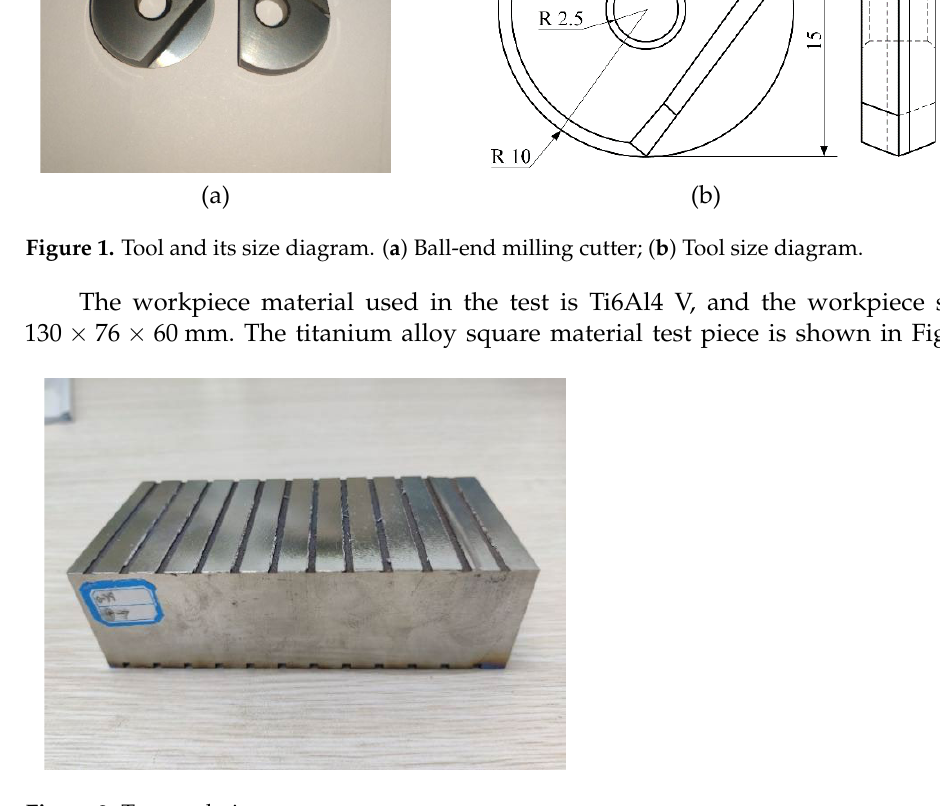
Figure 2. Test workpiece.